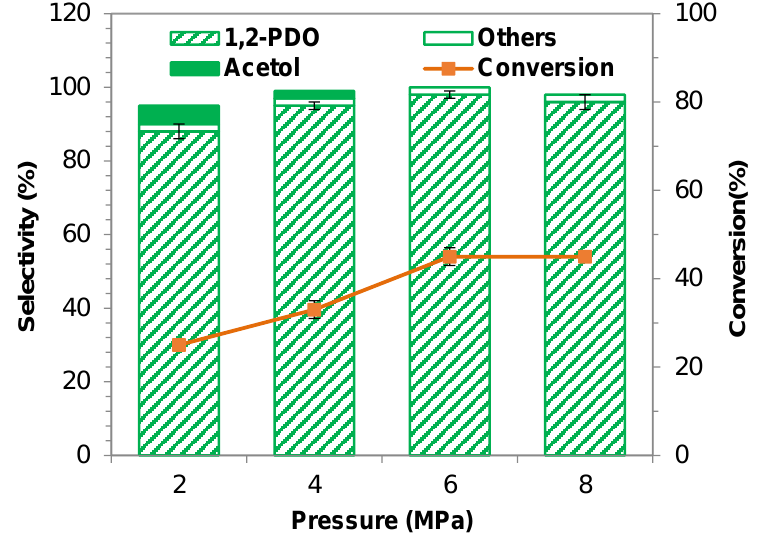
Figure 6. Effects of hydrogen pressure (2–8 MPa) on the performance of 5Cu-1B/Al 2 O 3 catalyst for glycerol hydrogenolysis (240 °C, 10 wt% aq. glycerol and WHSV 0.4 h −1 ).